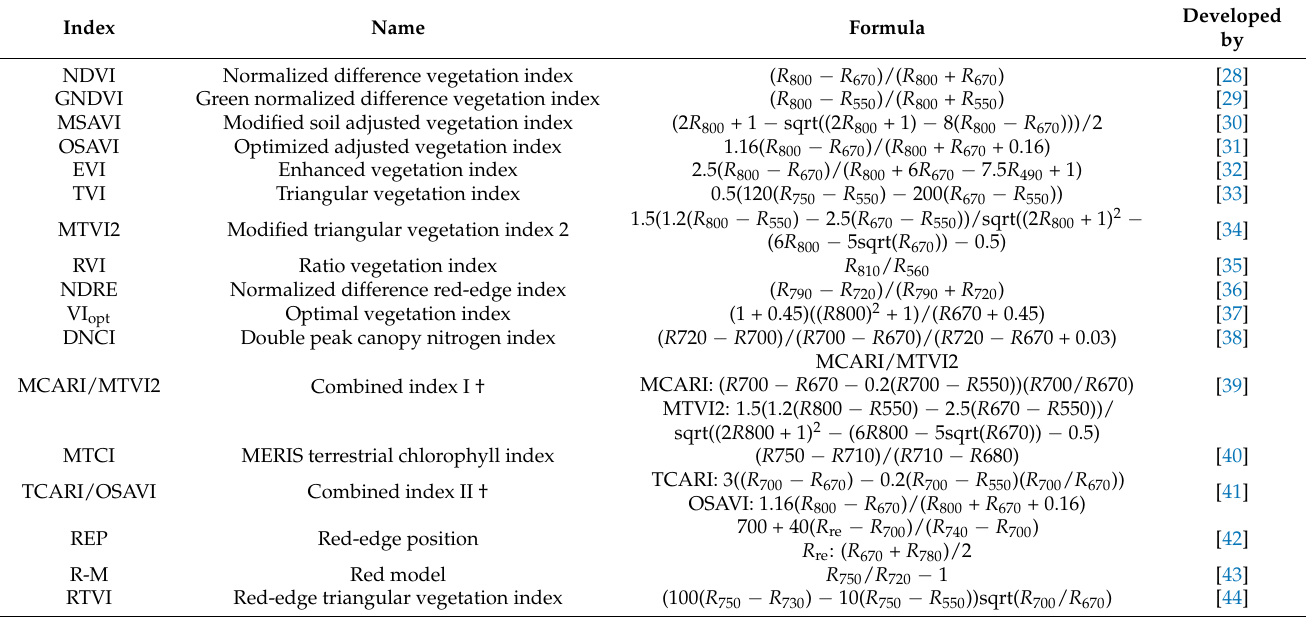
Table 1. Spectral indices used in this